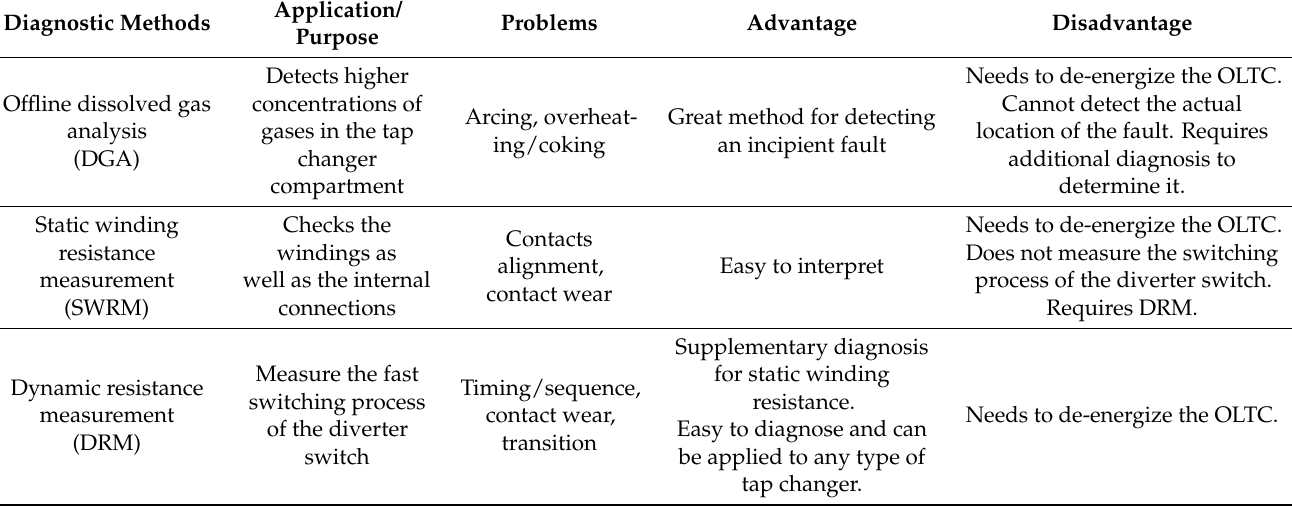
Table 5. Summary of offline monitoring